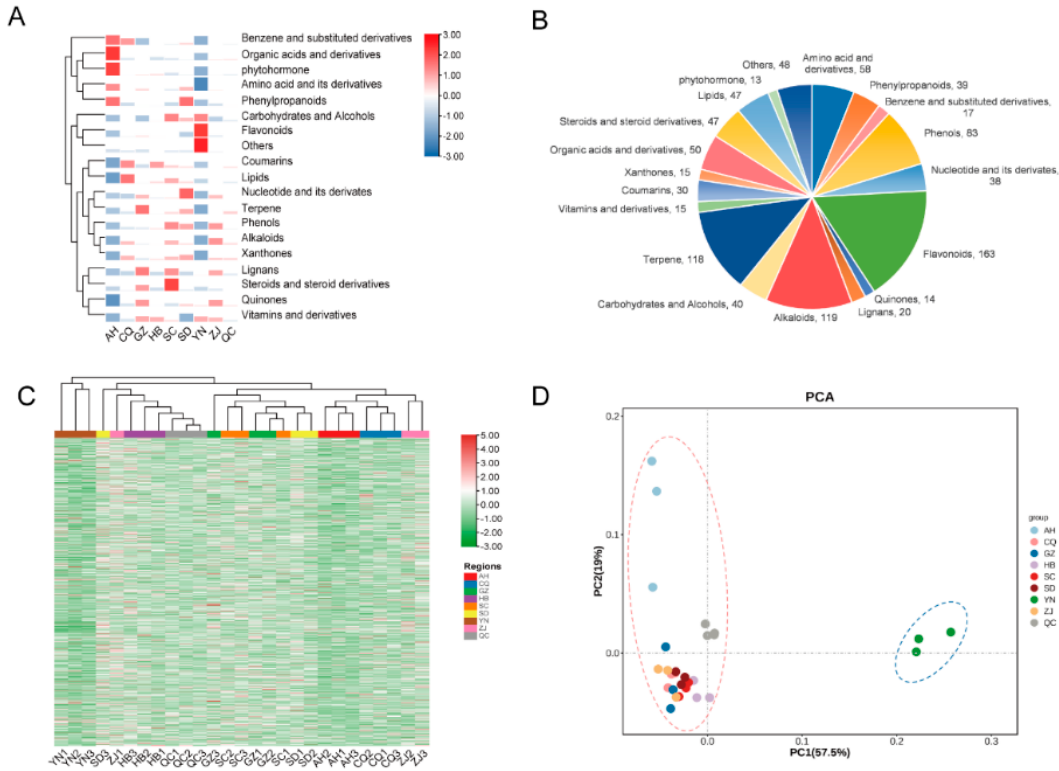
Figure 2. Heat map, pie graph, HCA and PCA, revealing the metabolic characteristics of C. speciosa fruits from eight regions. ( A ) The 974 metabolites were divided into 19 classifications, and the average value of these 19 classifications were related to 8 producing areas. ( B ) The 974 metabolites were divided into 19 classifications, and the number of compounds contained in each classification.